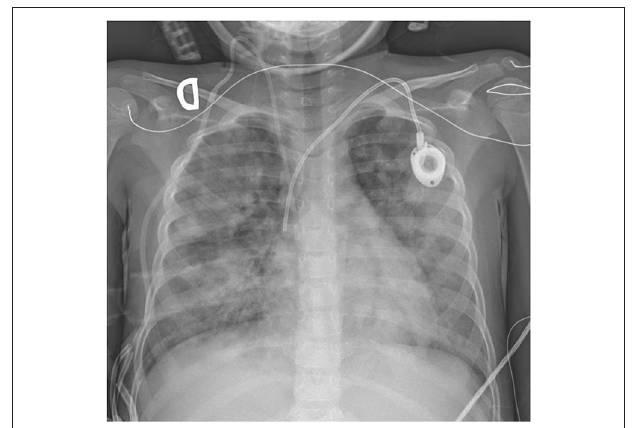
FIGURE 1 | Chest radiography on